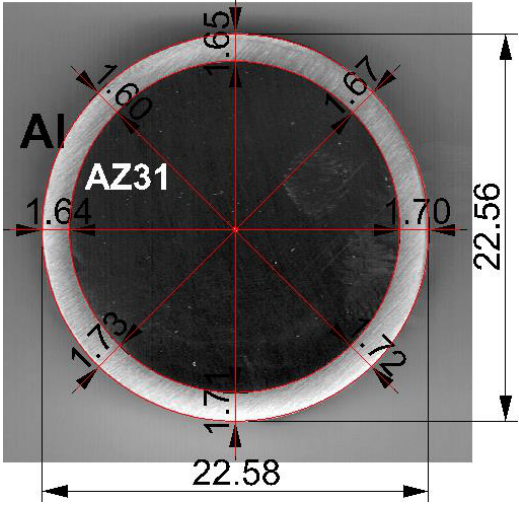
Figure 2. An exemplary shape of the Mg/Al bimetallic feedstock (cross-section) after explosive welding. One of the deciding factors impacting the even distribution of the plating layer is the shape of the grooves and the distribution of deformations in individual passes. Two systems of elongating grooves were designed for the rolling process: the classic system of grooves, oval-circle-oval-circle (variant I), and its modification, multi-radial horizontal oval-multi-radial vertical oval-multi-radial horizontal oval-circle (variant II). In the case of both variants, the rolling process took place in four passes. The finished round pass was the same in both variants. The rolling feedstock was round bars with 22.5 mm diameter and 100 mm length. After rolling, the obtained round bars had a 17-mm diameter.